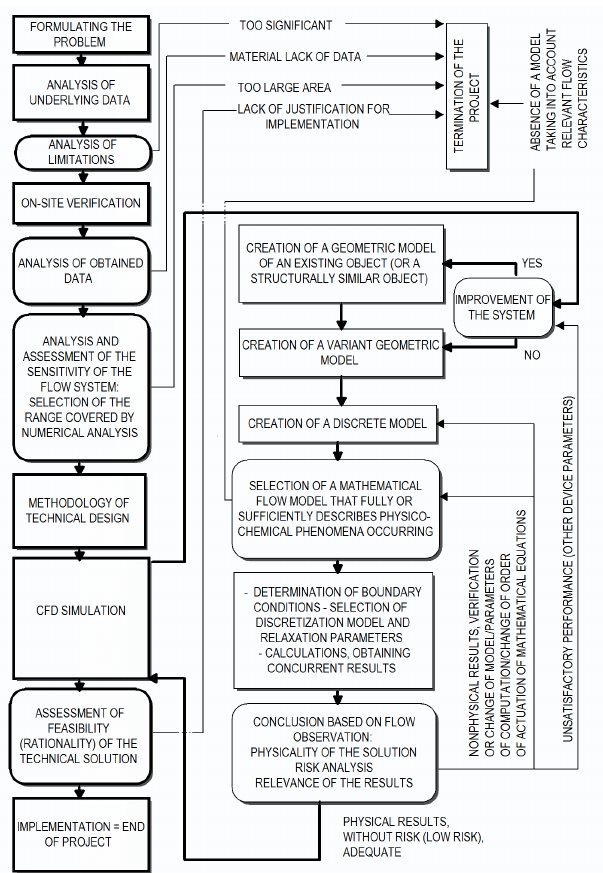
Fig. 2. Scheme of Zawiślak’s method ‘Design and modernisation of ma- chines and flow systems using CFD software’ [13] Based on the results of numerical simulation, a proto- Fig. 1. The research object – radiator with an air distribution system, type was created. In the next steps, the prototype was tested equipped with a set of fans, liquid and air temperature sensors, a wire under laboratory and field conditions in order to perform a harness adapted to communication via the CAN 2.0B bus, with a transmis- sion speed of 250 Kbps two-stage validation of the results of CFD calculations. The research methodology scheme is shown in Fig. 3.